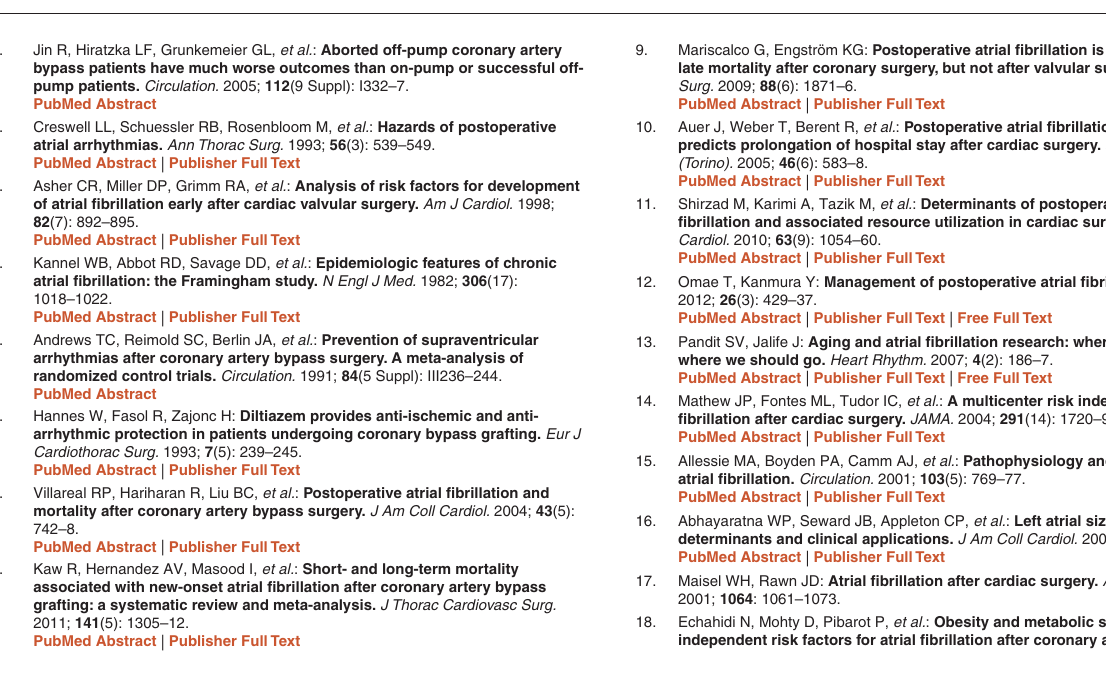
Supplementary File 1: Pre-formulated data collection